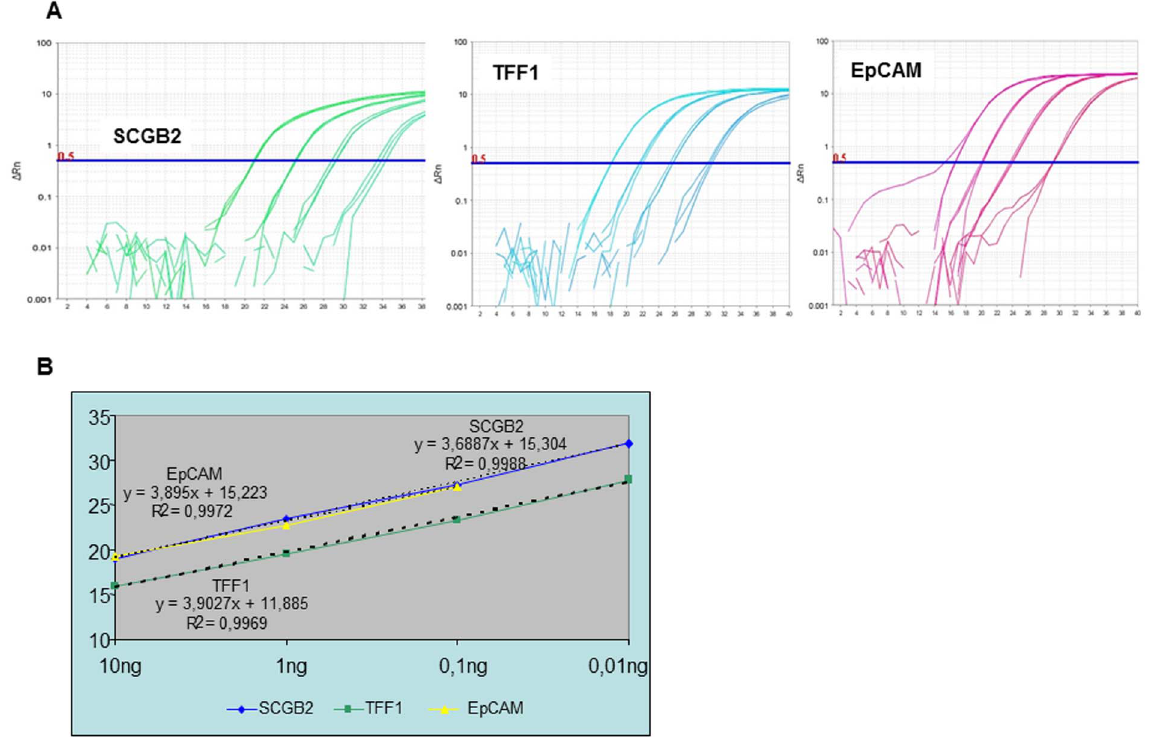
Figure 1. Efficiency, sensitivity and reproducibility of the assays. A) Amplification curves for a 10-fold dilution series for SCGB2 , TFF1 and Muc1 gene. As the template amount decreases, the cycle number at which significant amplification is seen increase. B) Example of a standard curve and illustration of amplification efficiencies between targets. A standard curve shows the quantification cycle (Cq) on the y-axis and the starting quantify of RNA on the x-axis. Slope, y-intercept, and correlation coefficient values provide information about the performance of the reaction.